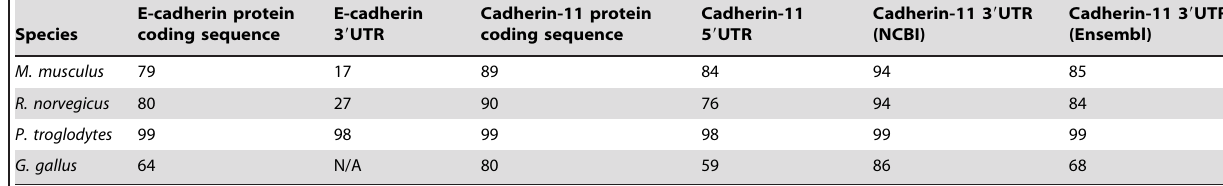
ClustalW Nucleotide Sequence Alignment compared to H.sapiens